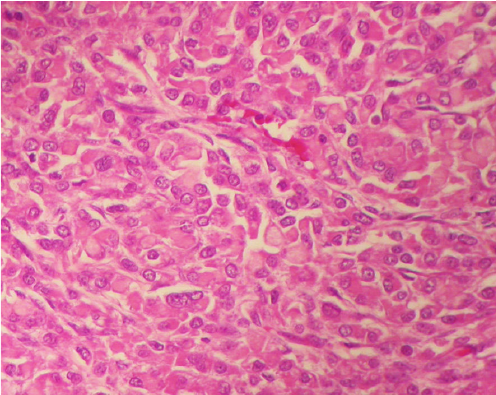
Figure 2: Columnar neoplasia made up of polygonal cells of eosinophilic cytoplasms, forming structures which look like the his- tological image that appears in well-differentiated